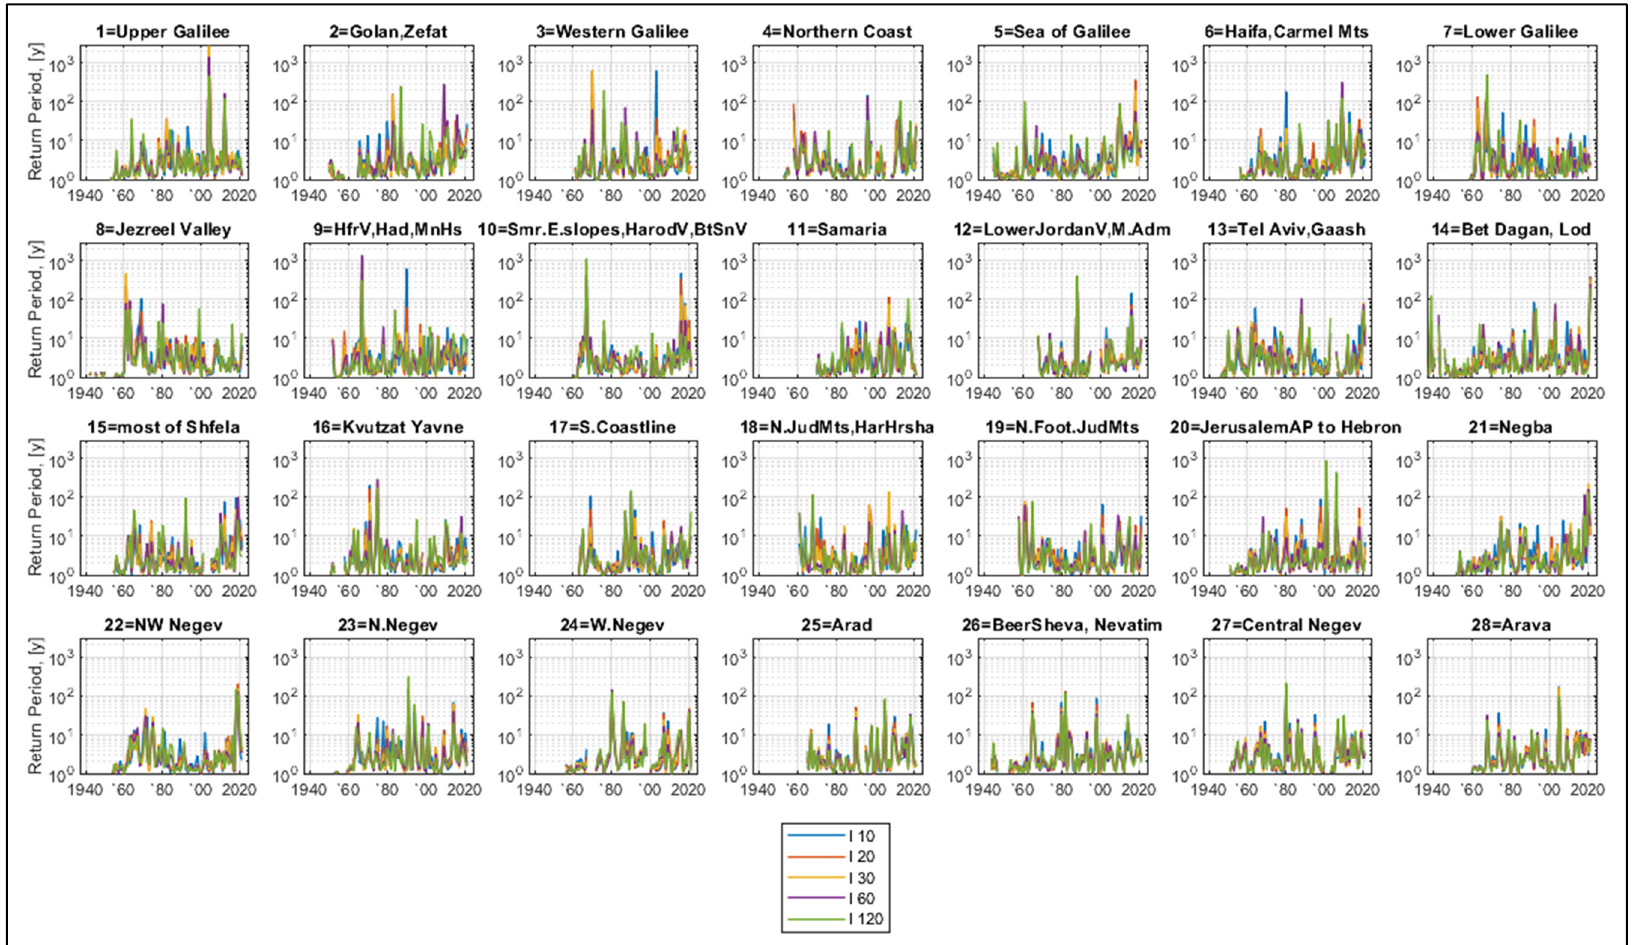
Figure 6. Return periods (RP). The RP for each annual maximum value was estimated with the GEV parameters fitted separately for each region and each short-time interval (from 10 to 120 min). All RP were estimated using Formulas (6) and (7).